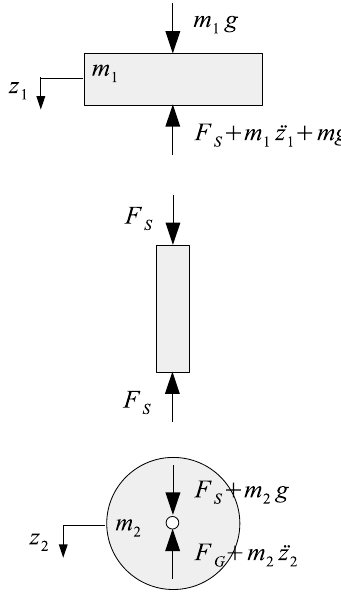
Fig. 1. Free-body diagram of landing gear (aircraft, strut and